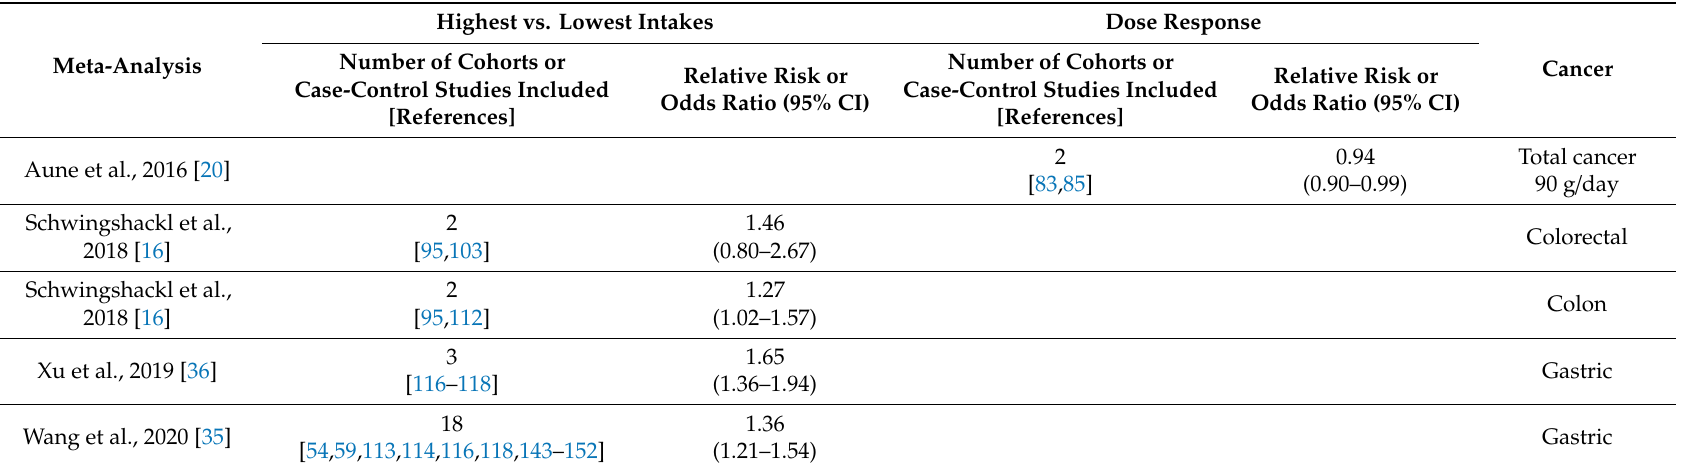
Table 3. Refined grain intake and cancer risk: Results from meta-analyses of observational cohort and case-control